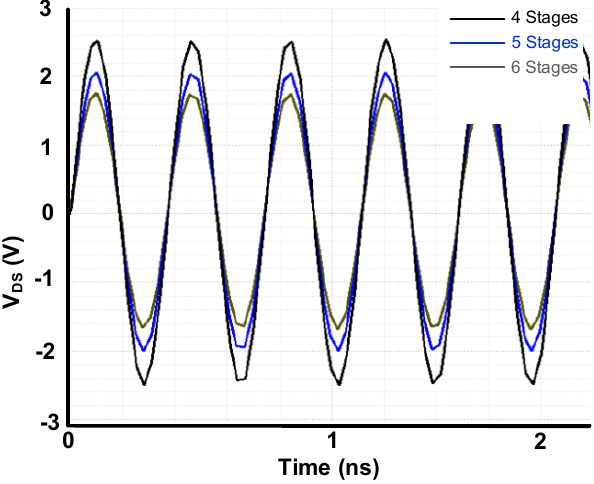
Figure 6. V DS of first transistor vs. number of stacks in series for OFF